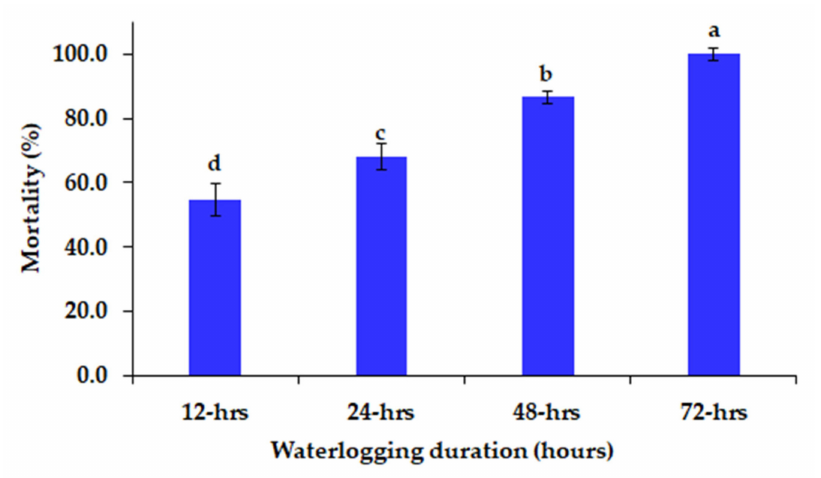
Figure 1. Mortality percentages of different sesame genotypes at the seedling stage under different durations of waterlogged conditions. The bars on the columns represent the SE, and different letters differ significantly by LSD ( p < 0.01).